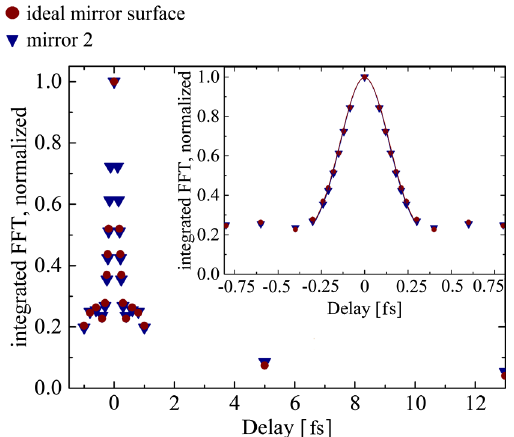
FIG. 10. A measurement of the temporal coherence properties of XFEL pulses for ideal mirrors (red dots) and real, nonperfect mirrors (blue triangles). The inset shows the magnified central peak with fitted Gaussian functions yielding a coherence time of τ 0 . 191 fs (HWHM) for perfect mirrors (red) τ c ¼ 0 . 187 fs (HWHM) for real, nonperfect mirrors